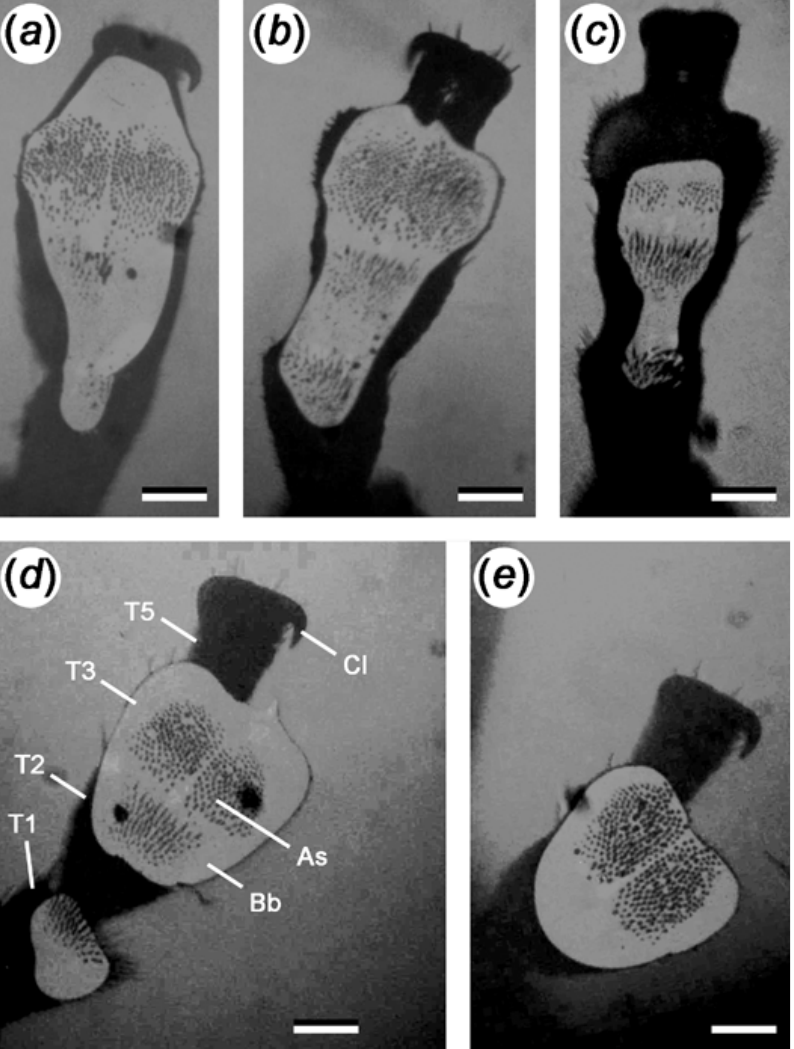
Figure 3. Images of the tarsal air bubble of G. nymphaeae beetles standing on glass slides underwater. Due to coaxial illumination, the air appears white and the contact area of attachment hairs on the glass slide appears black. As: Attachment setae. Bb: Subtarsal air bubble. Cl: Claw. T1–T5: Tarsal segments. Scale bars: ( a – e ): 0.1 mm.